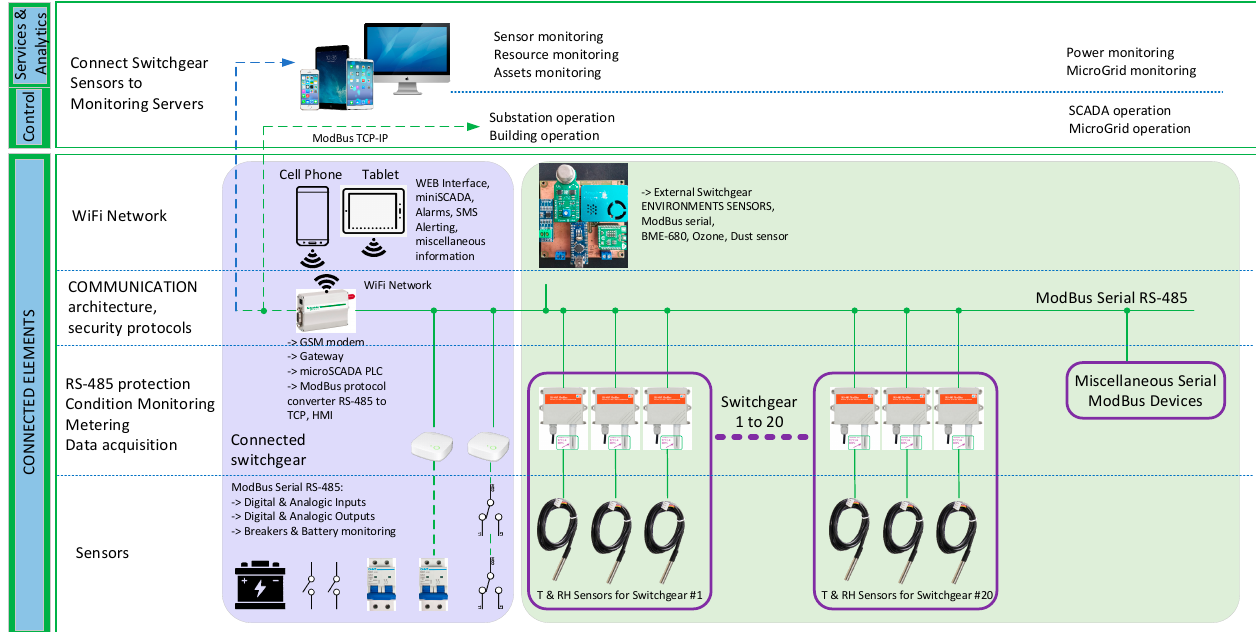
Figure 6. Hardware flowchart proposal for microclimate monitoring in LV/MV switchgear cells.